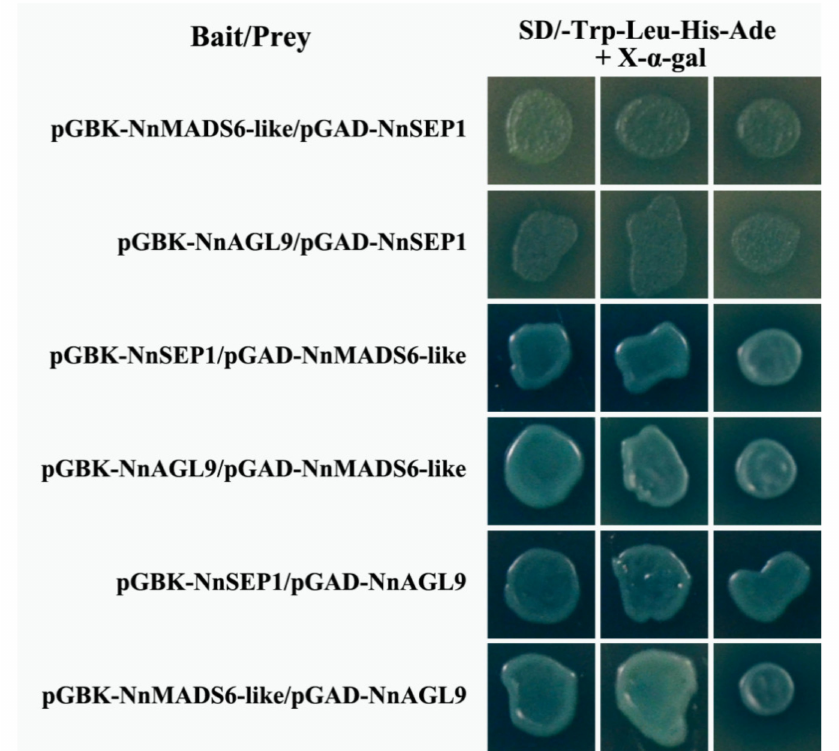
Figure 7. Protein interactions between NnSEP1, NnMADS6-like and NnAGL9 in vitro. Interactions were determined in yeast on selective medium SD/-Trp-Leu-His-Ade/X- α -Gal, and the experiments were repeated three times with the same results. AD and BK clones containing empty vectors were used as the negative controls, shown in Figure